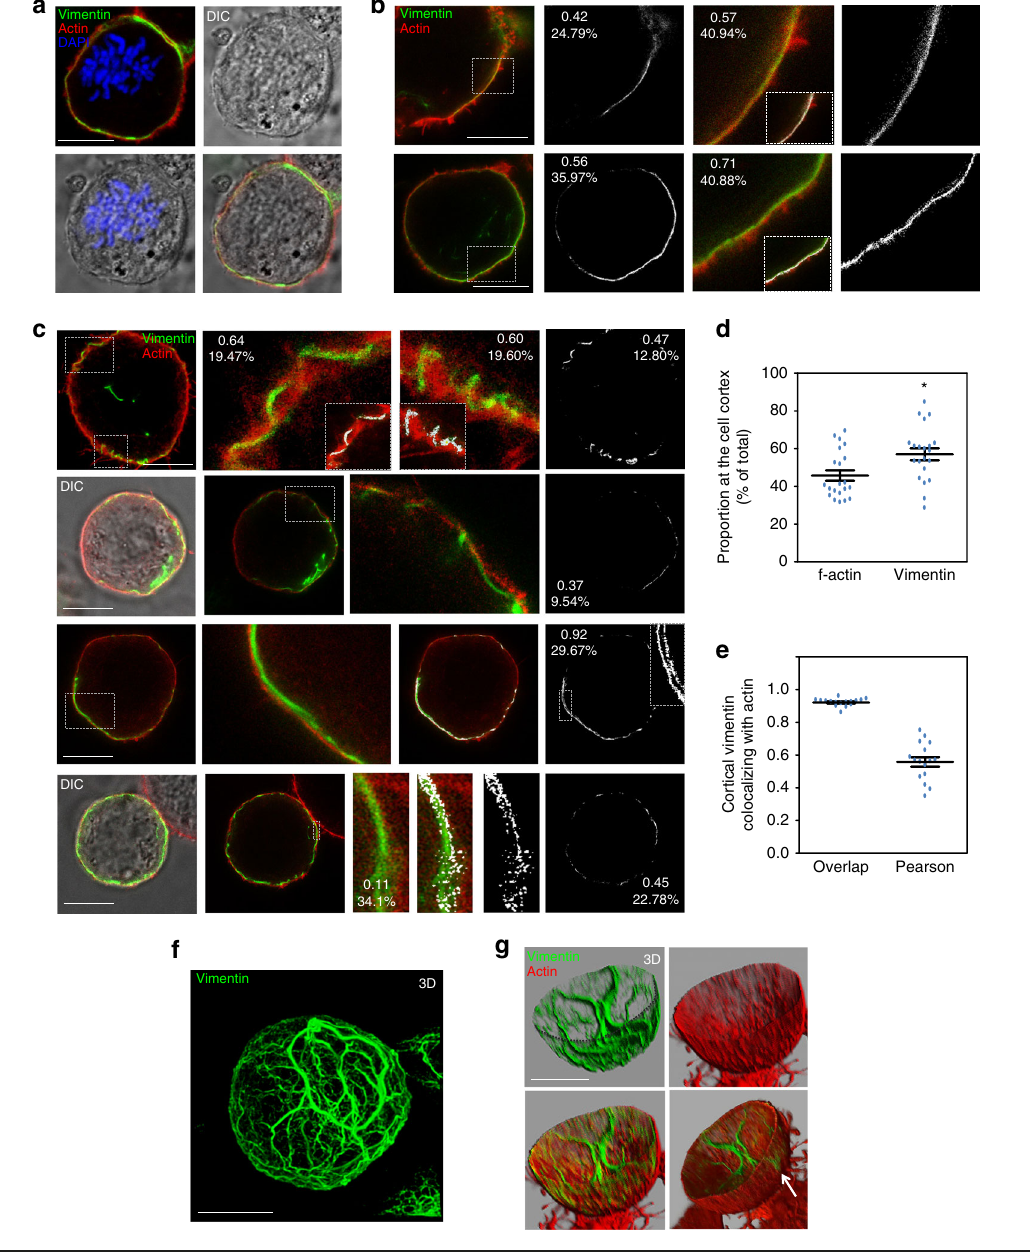
Fig. 5 Analysis of the relative positions of vimentin and actin in mitosis by STED superresolution microscopy. a Confocal microscopy images illustrating the identi fi cation of mitotic Vero cells by the typical aspect of dividing chromosomes in DIC, con fi rmed by DAPI staining in merged images. The distribution of f-actin and vimentin was monitored by TRITC-phalloidin staining and immuno fl uorescence with Alexa488-conjugated V9 antibody, respectively. b Mitotic Vero cells, identi fi ed by DIC visualization, were analyzed by STED and images of several cells are shown. Colocalization masks (shown in white) or enlargements of areas delimited by dashed rectangles are shown to the right. Co-localization analysis was performed with Leica software. Numbers in insets represent the Pearson ’ s coef fi cient and the percentage of co-localization for the regions shown. c SW13/cl.2 cells stably transfected with RFP// vimentin wt were treated with 0.4 µ M nocodazole overnight, to increase the proportion of mitotic cells. Vimentin and f-actin were detected as above. STED images of several cells are shown. Overlays with DIC images are confocal images. Colocalization masks (white) or enlargements of areas delimited by dashed rectangles are shown to the right. Numbers in images represent the Pearson ’ s coef fi cient and the percentage of co-localization, respectively, for the whole cell or for the regions enlarged. d Proportion of f-actin or vimentin located at the cell periphery ( n = 21, * p < 0.02 by two-tailed, unpaired Student ’ s t -test). e Colocalization of cortical vimentin with f-actin analyzed by calculation of overlap and Pearson coef fi cients for the cortical ROI ( n = 16). Datasets for d and e are provided in the Source Data fi le. Average values ± SEM are shown. f 3D-reconstruction of vimentin organization, after deconvolution of the green channel using Imaris software, for one representative cell treated as in c . g 3D-reconstruction using the basal half of the sections from the same cell in order to show the inside and the outside of the sphere. Single channels (upper panels) and merged images (lower panels) are shown. The semi-sphere edge is marked in the green channel (dotted line). The bottom-right image is a snapshot of Supplementary Movie 5. The arrow points at a protrusion of vimentin through the actin cortex. Scale bars, 10 μ